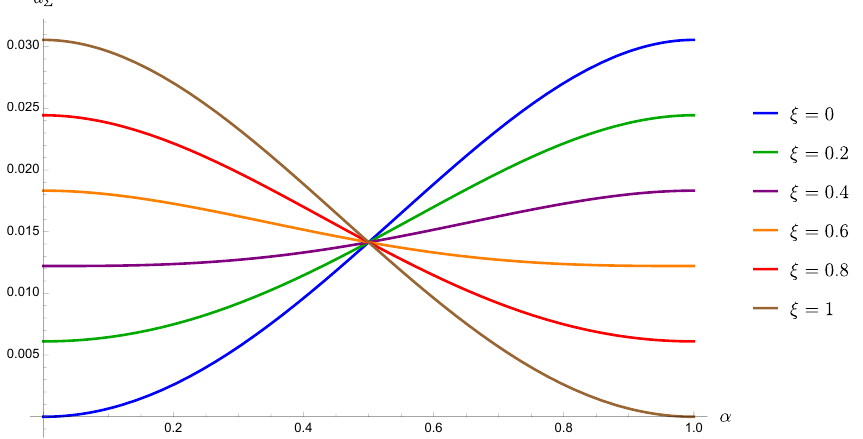
Figure 5 . Behavior of a Σ as a function of α for a monodromy defect in a theory of a single free Dirac fermion in d = 6 for various values of ξ . Note that when α = 1 / 2 , a Σ is independent of ξ